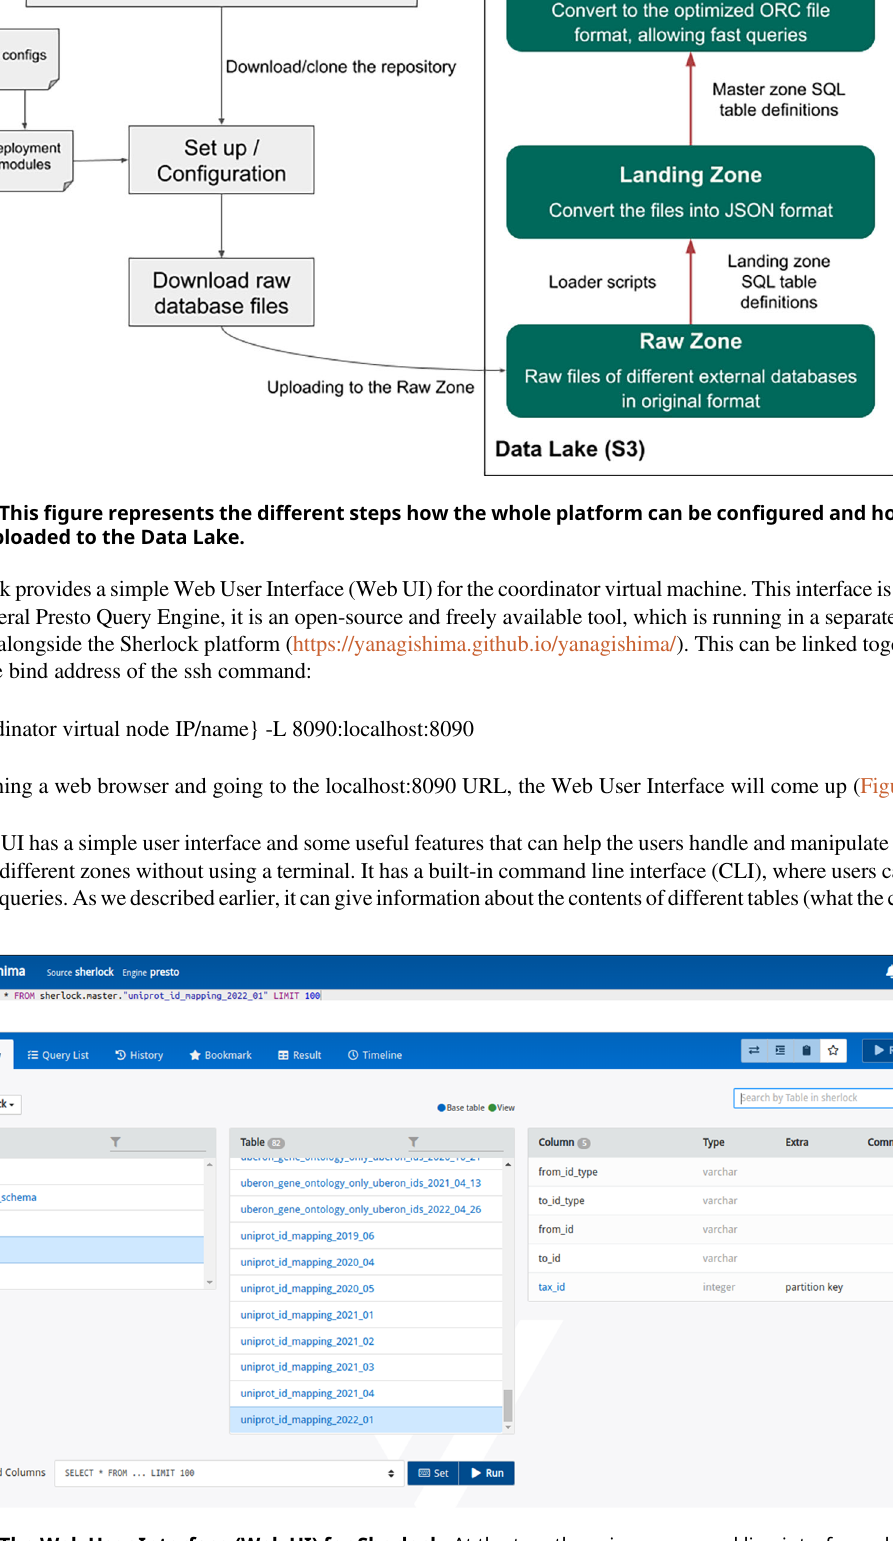
Figure 7. The Web User Interface (Web UI) for Sherlock. At the top, there is a command line interface where the user can write SQL queries manually. From left to right are the zones (schemas), the tables inside the zones, and the column structure of the table of